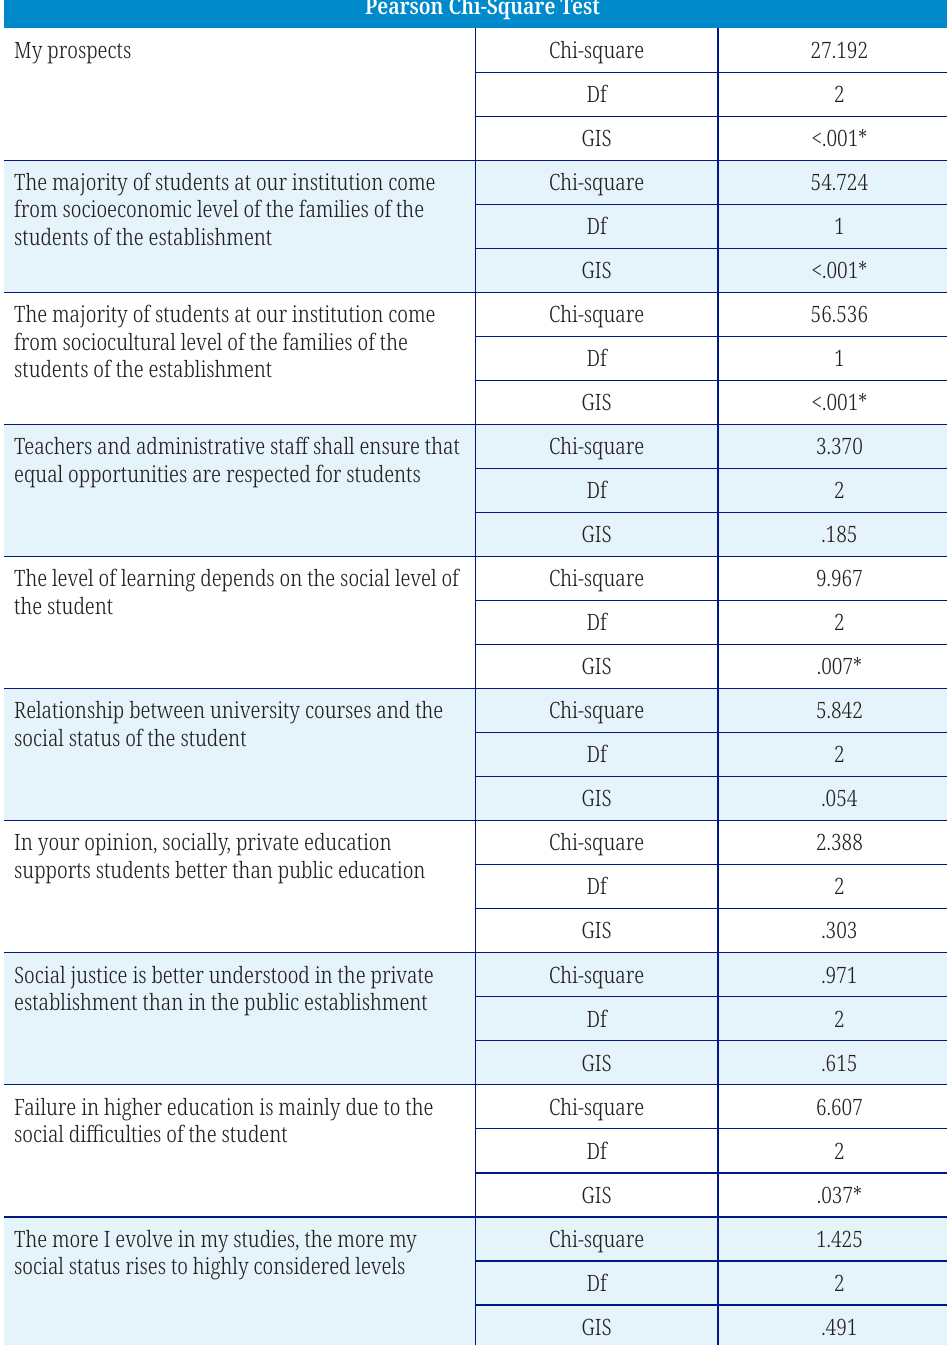
Table 14. Pearson chi-square test: social inequality representations and perceptions by public/private university students Pearson Chi-Square